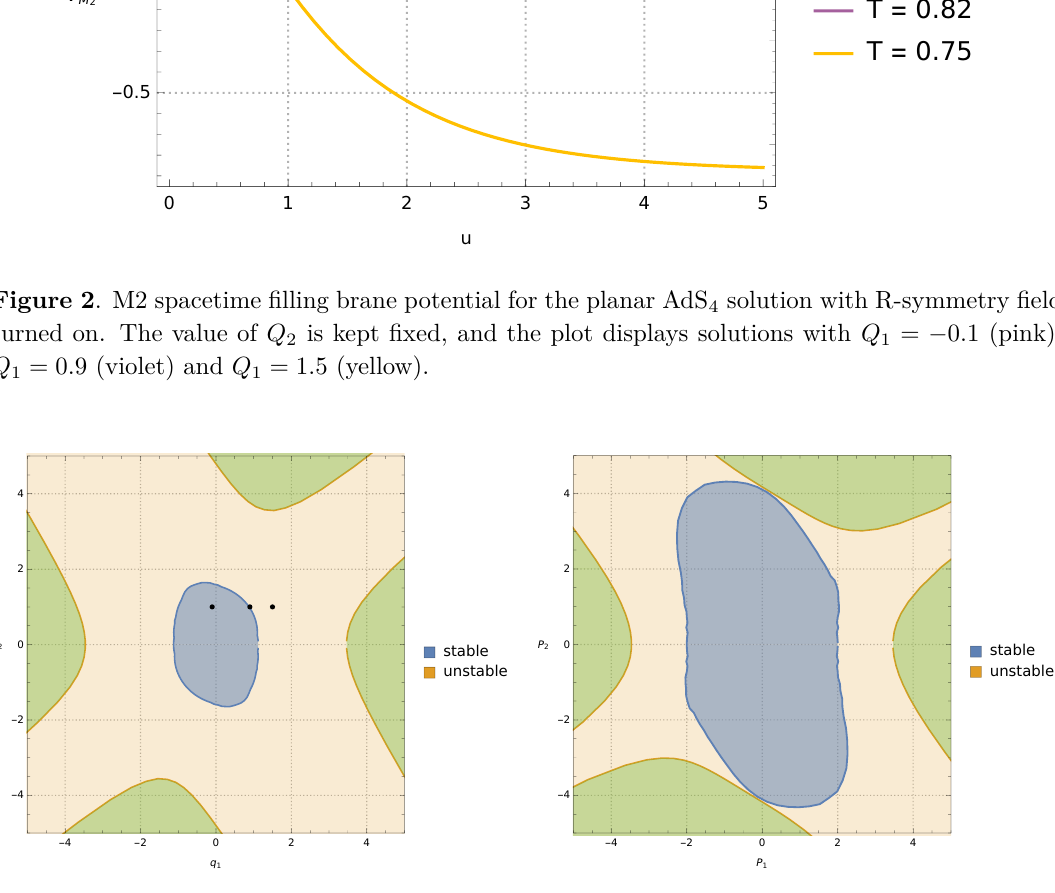
Figure 3 . In blue, the region of parameter space where the black branes are stable with respect to nucleation of spacetime filling M2 branes. The orange region contains unstable solutions. No black brane solutions exist in the green area, as they would be over-extremal. The graph on the left refers to purely electric black branes (the black dots refer to the three solutions plotted in figure 2), the one on the right to purely magnetic ones, both with R-symmetry gauge field turned on. The stability result of [29] corresponds to the vanishing unstable region on the P where the blue and green regions